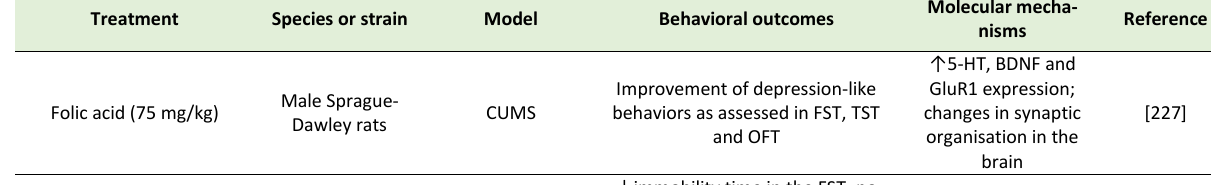
TABLE 8. Studies investigating the effects of folate on depressive-like behavior. Treatment Species or